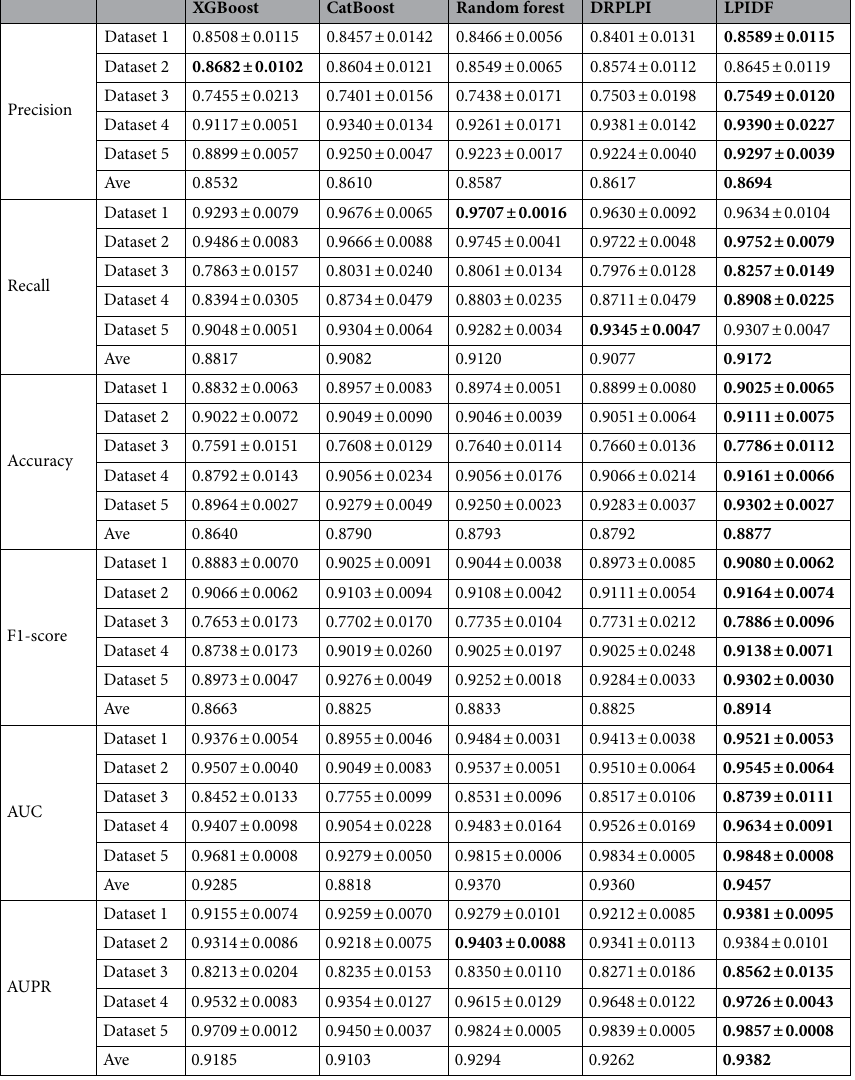
Table 3. The performance of five LPI prediction methods on CV3. The best performance is represented in boldface in each row in each